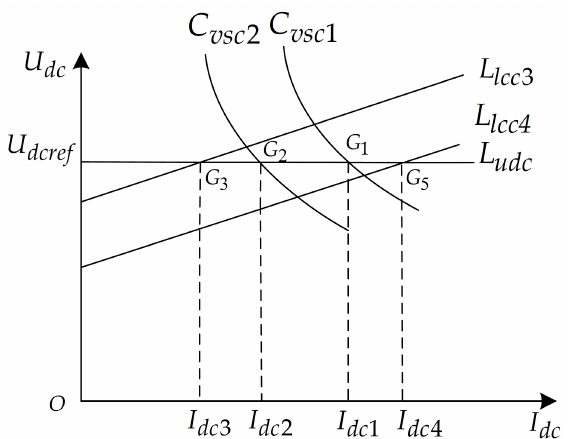
Figure 5. The operational characteristics of the four-terminal hybrid HVDC system.